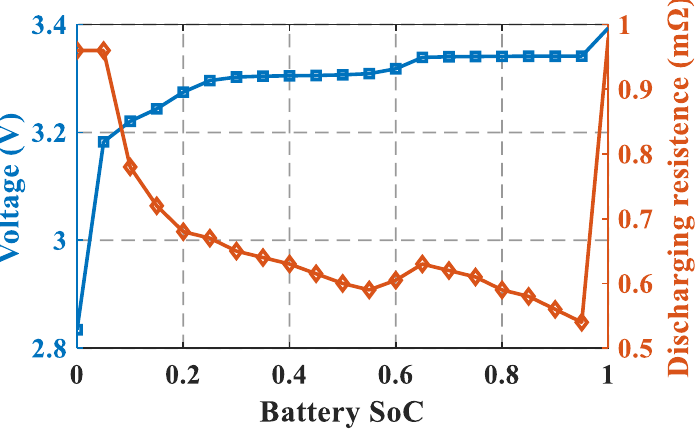
Figure 7. Efficiency map of the two motors: ( a ) the efficiency map of the driving motor and ( b ) the efficiency map of the working motor.